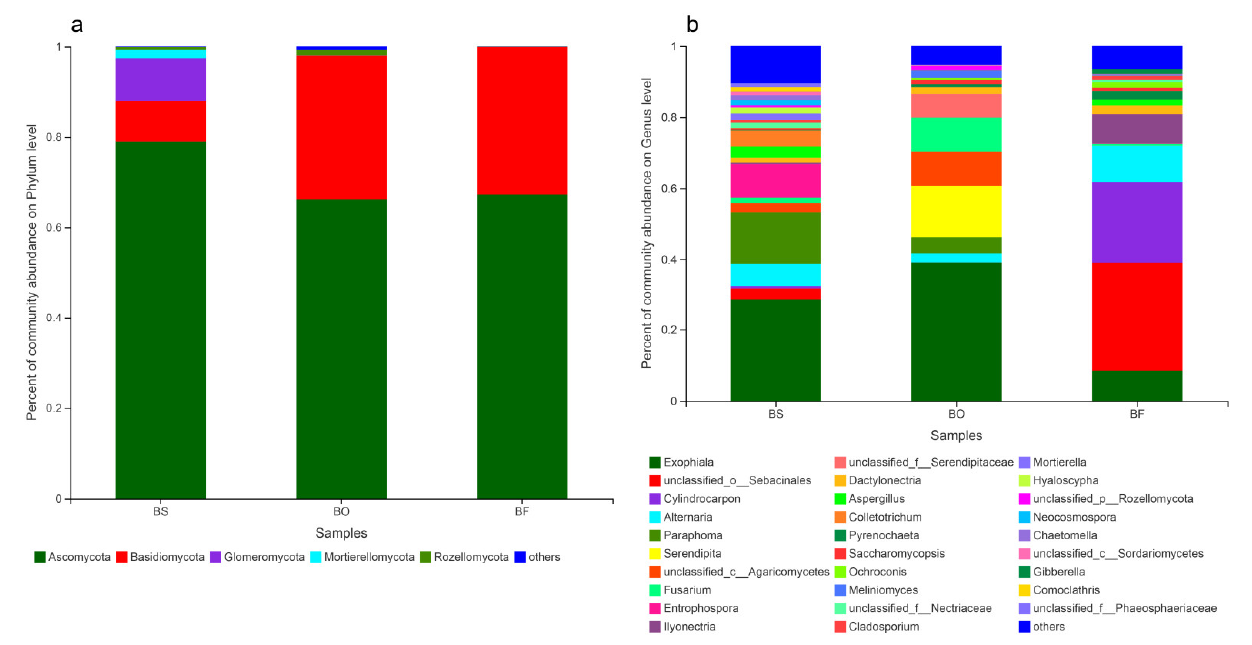
Figure 4. Relative abundances of different fungal phyla ( a ) and genera ( b ) in root endophytic fungi among three Bletilla species. BS, BO, and BF represent B. striata , B. ochracea , and B. formosana , respectively.